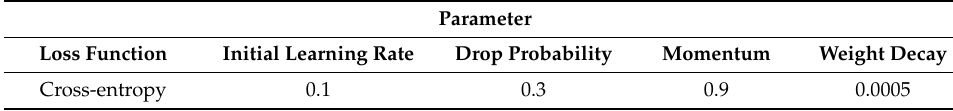
Table 2. The parameter in experimental